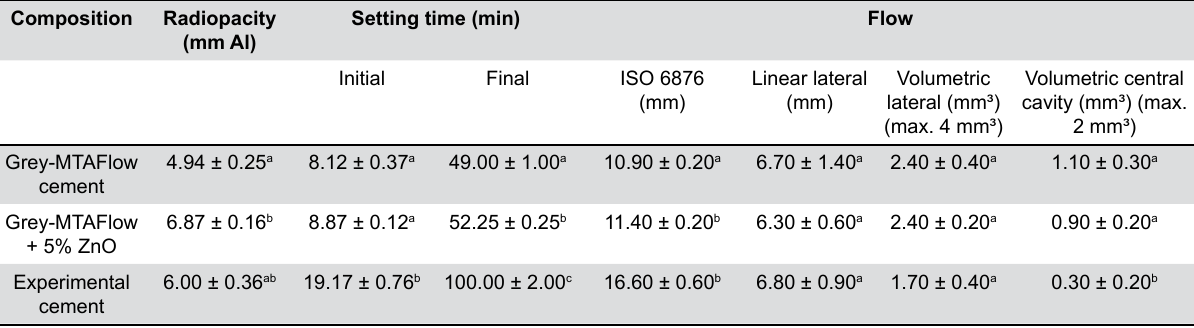
Table 2- Mean and standard deviation values of radiopacity, setting time, and flow. Different lowercase letters in each column indicate statistically significant differences between the tested materials